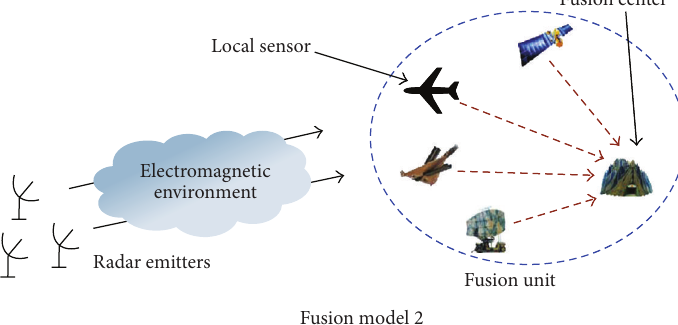
Figure 6: Different kinds of platforms fusion model. The fusion unit in fusion model 2 could be composed by several kinds of sensors, such as fighter, satellite, unmanned aerial vehicle (UAV), or passive radar. The radar emitter signal intercepted by several kinds of sensors from different space and the initial classification results of these signals are sent to the fusion